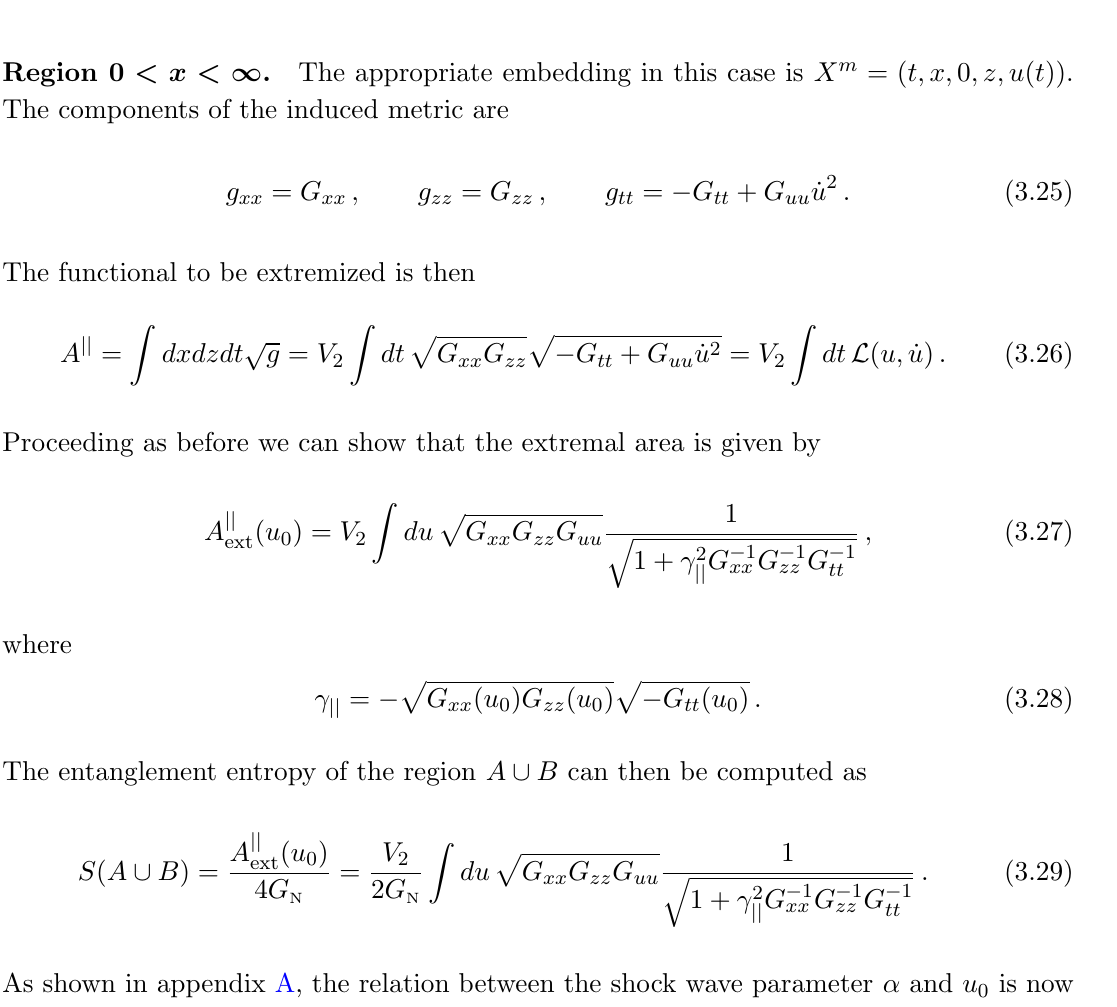
Figure 5 . Extremal surface (horizontal, red) in the shock wave geometry. Following [26], we divide the left half of the surface into three parts, I , II and III . The segments II and III have the same area and they are separated by the point u 0 at which the surface de(cid:12)ned by u = u 0 (blue, dashed curve) intersects the extremal